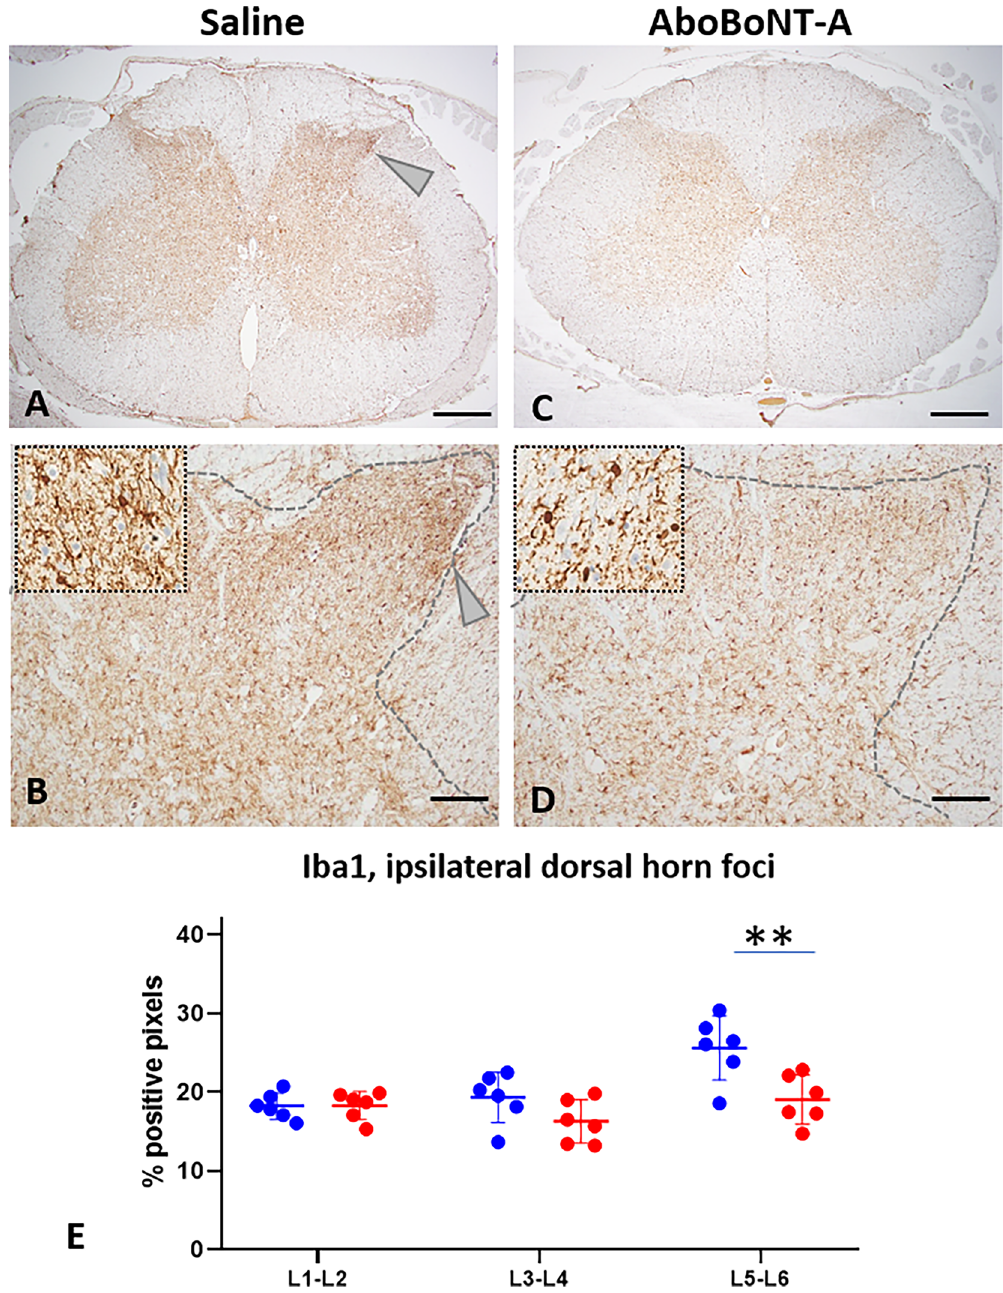
Figure 6. Iba1 immunolabelling in the lumbar spinal cord of saline- and aboBoNT-A- treated animals. Photomicrographs are taken from L5-L6 sections of representative animals that received a full-skin and muscle incision and retraction surgery (Day 0), followed by intraoperative treatment with either saline ( A, B ) or aboBoNT-A 400U ( C, D ) and tissue collection on Day 6. Insets in panels ( B ) and ( D ) depict Iba1 stained microglia in saline- ( B ) and aboBoNT-A-treated ( D ) animals. Panel ( E ) shows quantification of Iba1 immunolabelling in the foci with high intensity labelling (arrowhead) from lumbar (L) sections 1–2, 3–4, and 5–6 in representative animals (n = 3/group) treated with either saline (blue symbols) or aboBoNT-A (red symbols; n = 2 sections per animal) as well as their mean values (± SEM). Scale bar: 1 mm ( A, C ), 200 µm ( B, D ). **p < 0.01 vs saline-injected animals. Ionized calcium-binding adaptor protein-1, Iba1; AboBoNT-A, abobotulinumtoxinA; U,